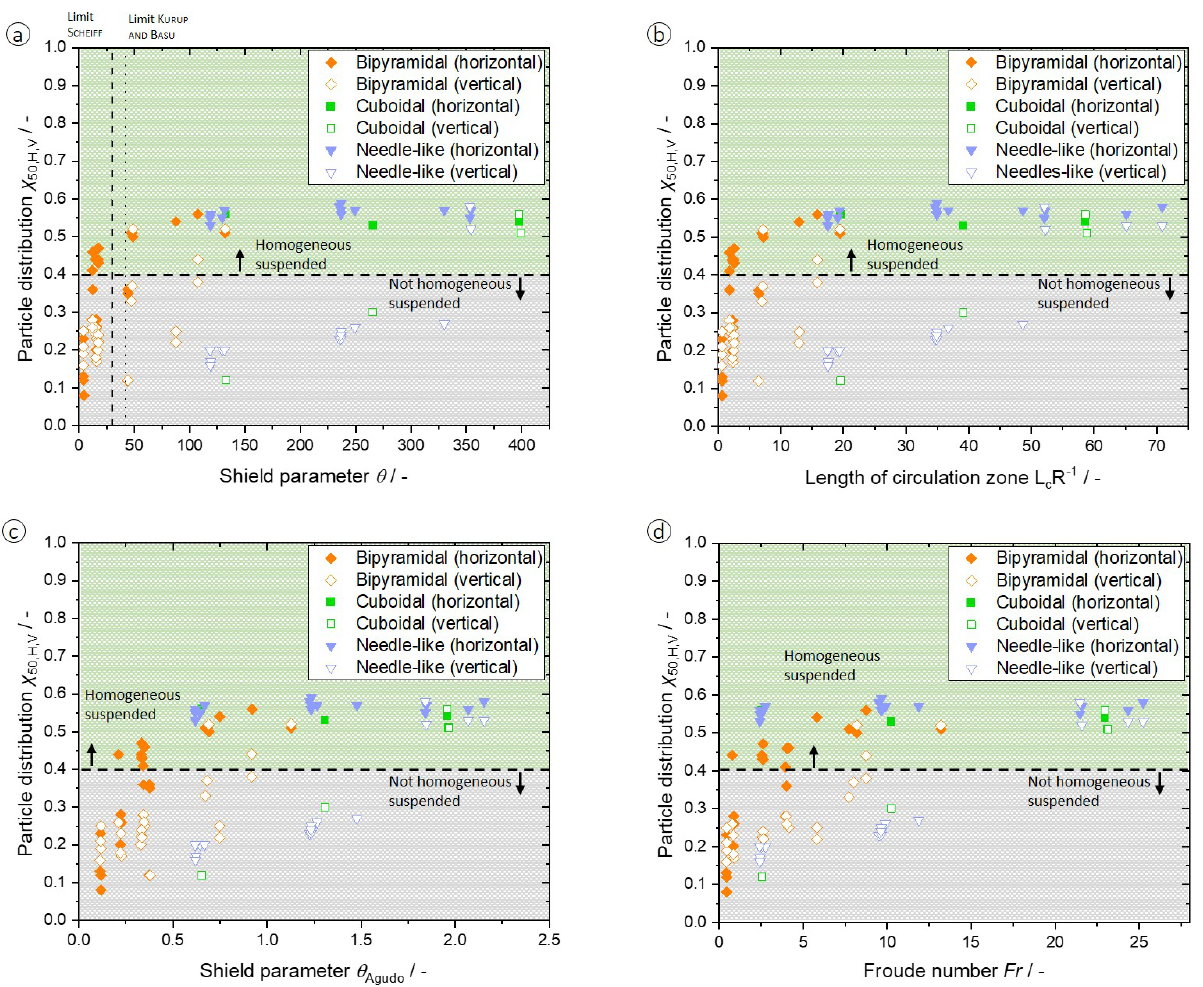
Figure 4. Particle distribution parameters χ 50,H and χ 50,V are plotted against the Shield parameter θ ( a ), the length of circulation zone L c R − 1 ( b ), the Shield parameter defined by Agudo et al. [34] θ Agudo ( c ), and the Froude number Fr ( d ) for various particle shapes. The used data are given in the Supporting Information in Tables S1 and